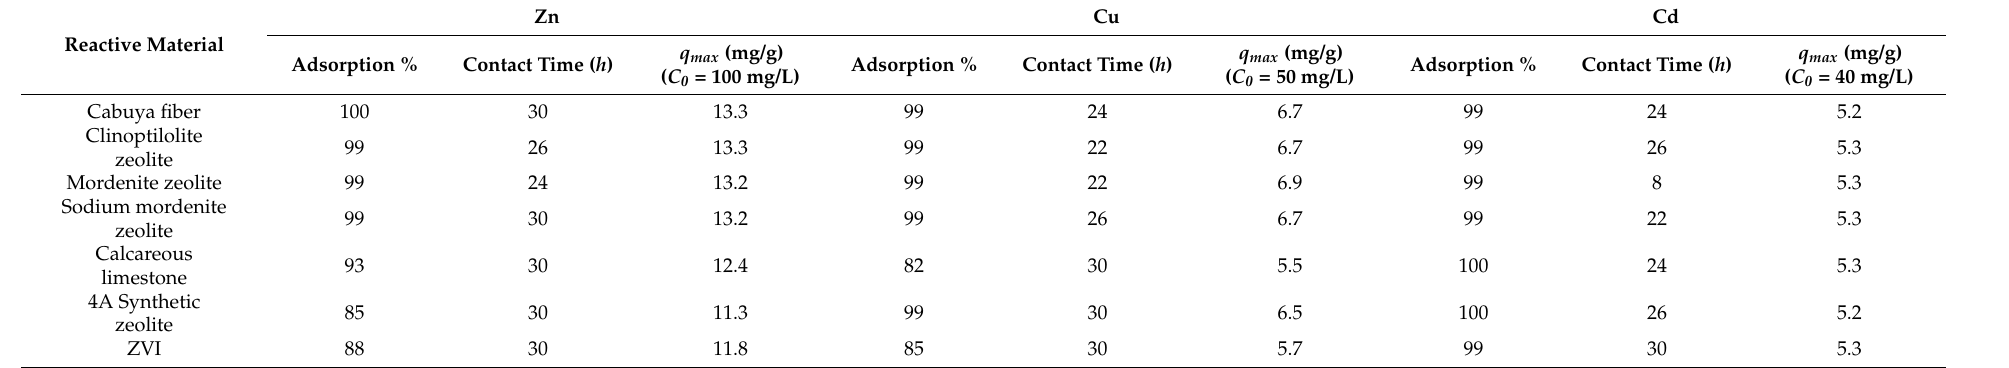
Table 3. Amount of metal adsorbed per unit of adsorbent mass under equilibrium